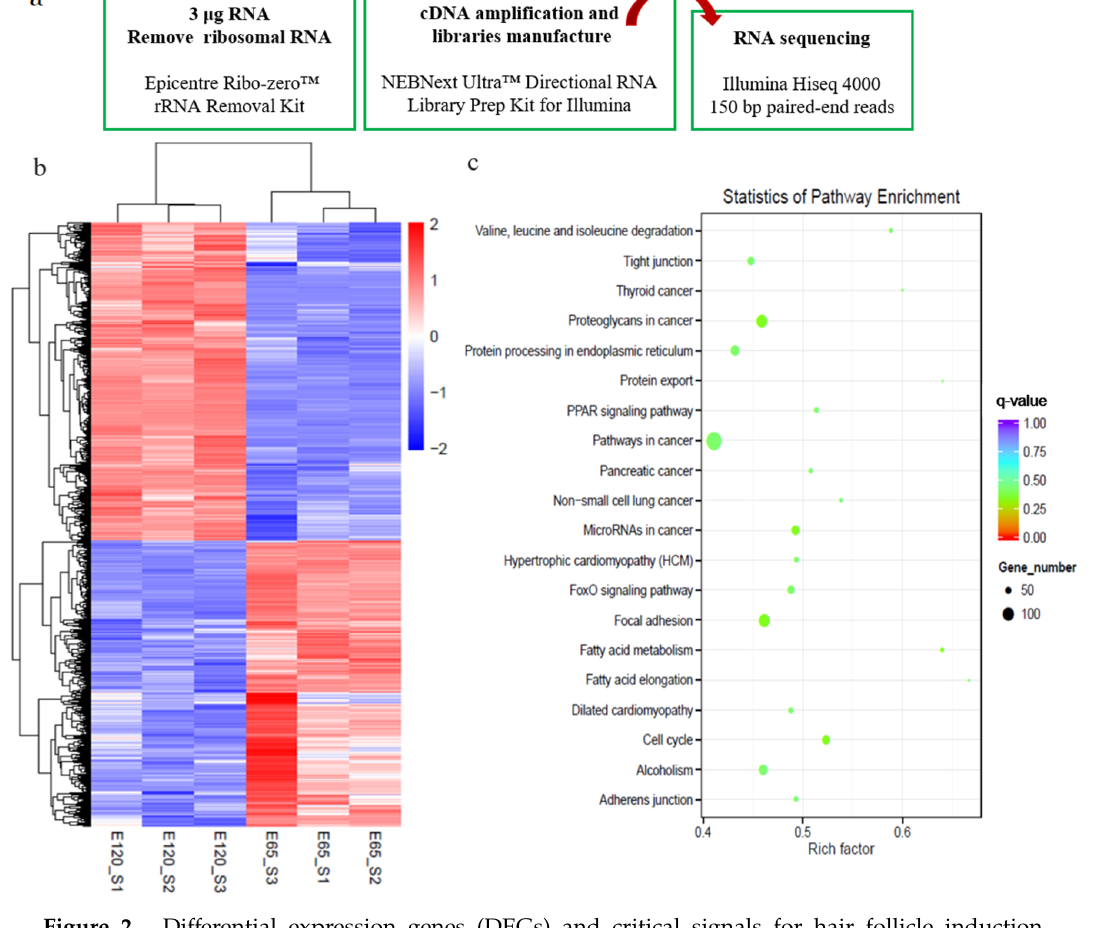
Figure 2. Differential expression genes (DEGs) and critical signals for hair follicle induction and differentiation stages were revealed by RNA-seq. ( a ) Workflow of the sample preparation for RNA-seq. ( b ) The heatmap of DEGs between E 65 and E 120. ( c ) Kyoto Encyclopedia of Genes and Genomes (KEGG) analysis of DEGs between E 65 and E 120. In total, 1729 downregulated genes and 1937 upregulated genes were identified in E 120 compared with E 65.